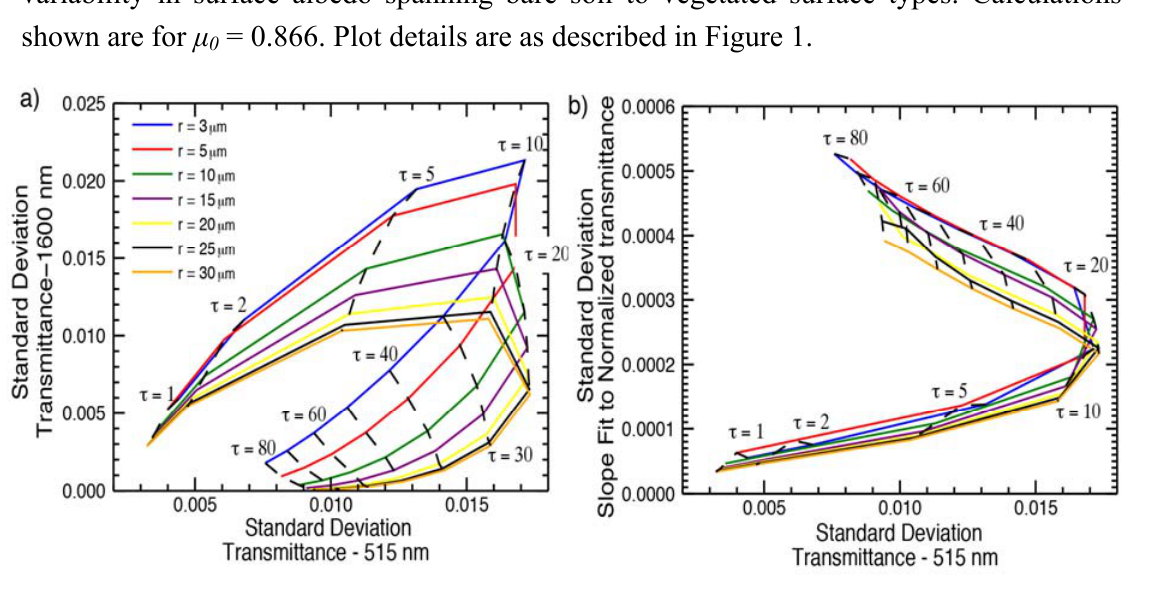
for ( a ) the standard e